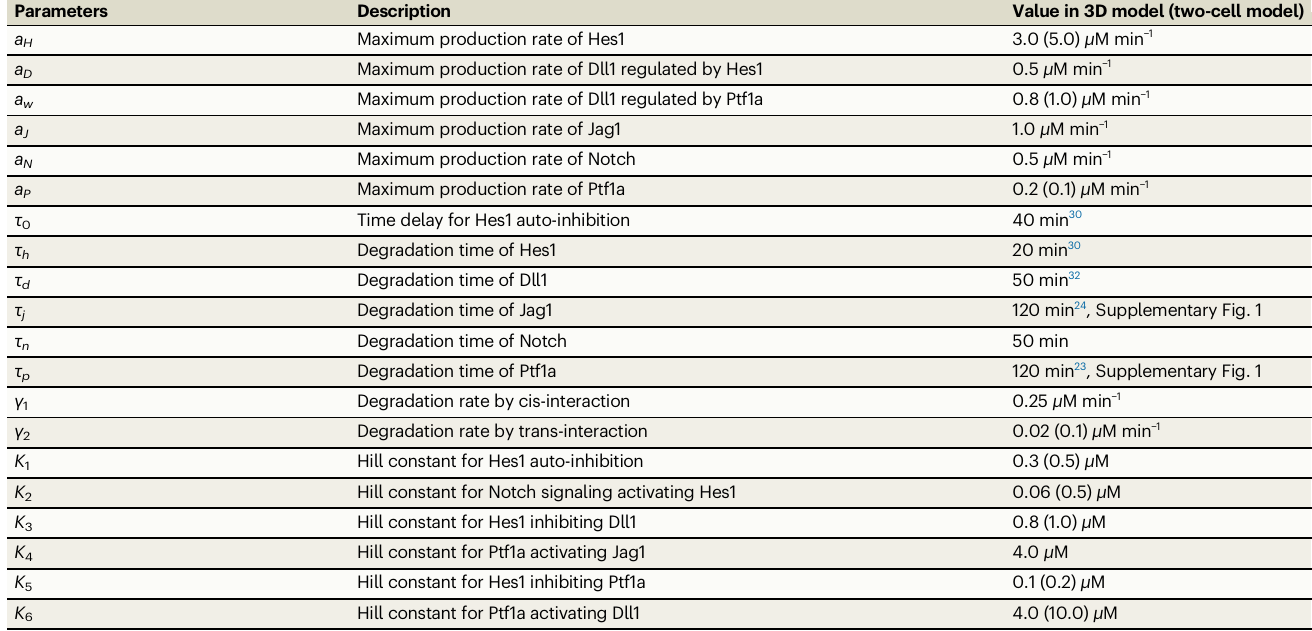
Table 1 | Parameters (italic) used in the simulation of gene expression dynamics